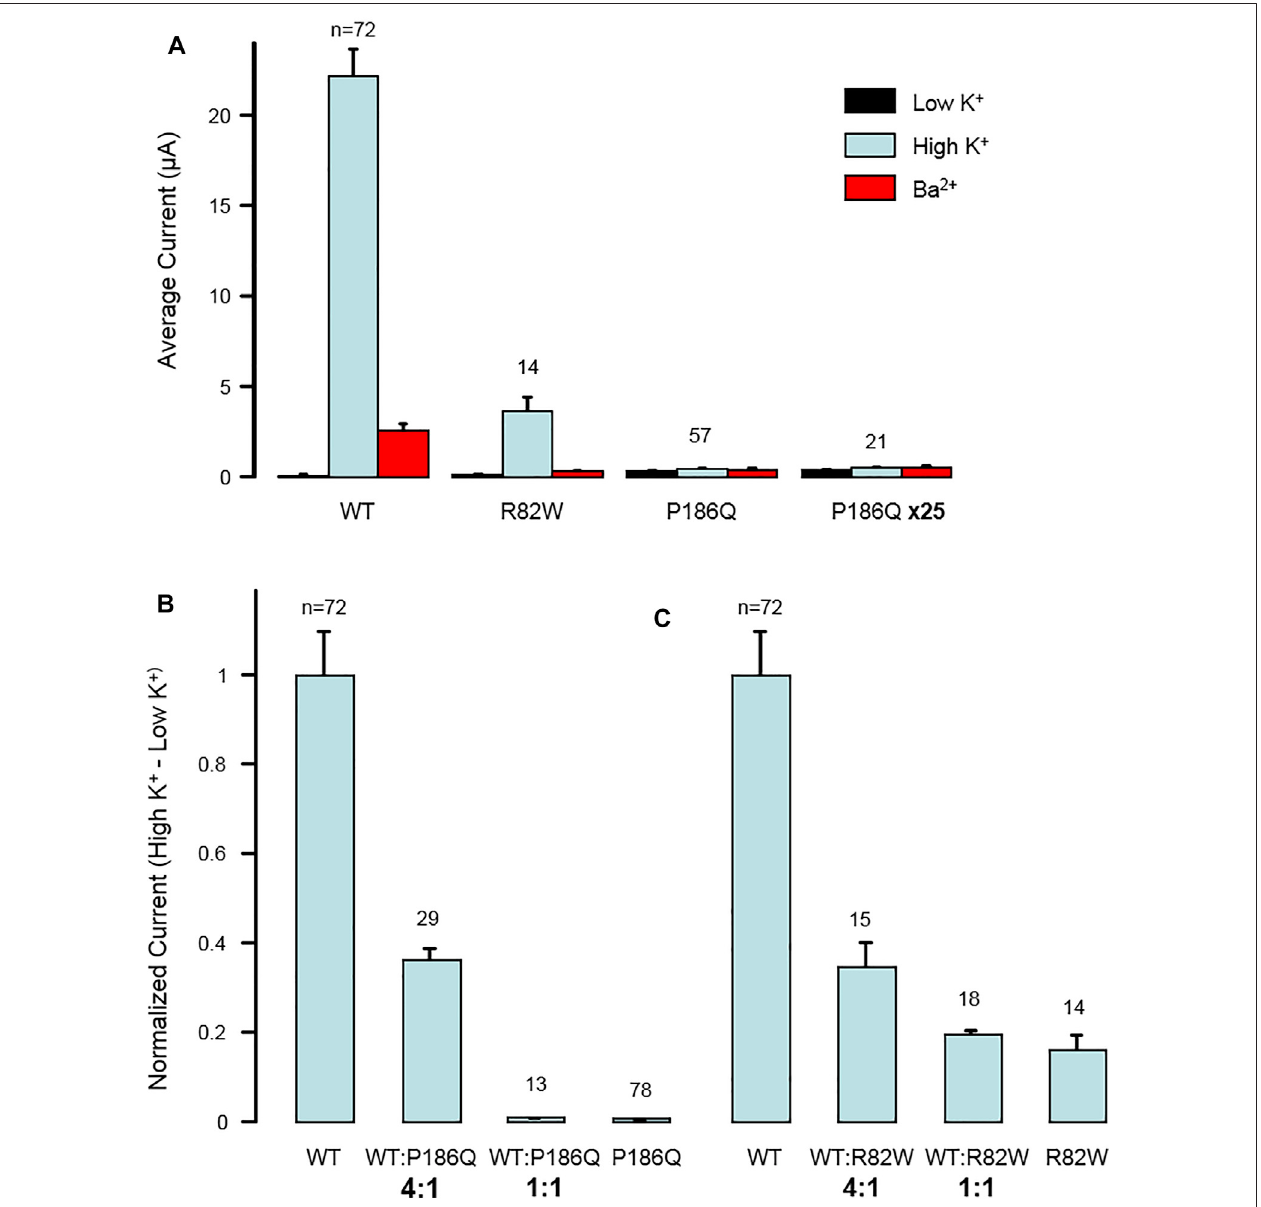
FIGURE 2 | Dominant negative effect of mutations p. Arg82Trp (R82W) and p. Pro186Gln (P186Q) on Kir2.1 function. (A) Mutations reduce the activity of homotetrameric channels. The histogram displays the average whole-cell currents recorded in Xenopus oocytes injected with 2 ng of RNA coding for either wild-type Kir2.1 ( WT ), Kir2.1 R82W ( R82W ), or Kir2.1 P186Q ( P186Q ). Oocytes injected with 50 ng of Kir2.1 P186Q were also tested ( P186Q x25 ). Measurements were done successively in extracellular solutions containing 2 mM K + ( Low K + ), 96 mM K + ( High K + ), and 3 mM Ba 2+ and 96 mM K + ( Ba 2+ ). (B,C) Effect of mutations varies graduallywiththeratioofWTtomutantsubunits. (B) Thehistogramdisplaystheaveragewhole-cellcurrentsrecordedinXenopusoocytesinjectedwithRNAscodingfor wild-typeKir2.1( WT )orKir2.1 P186Q ( P186Q ),orwithamixtureofRNAscodingforWTandmutantwithratiosof4:1or1:1.Thecurrentswerecalculatedasthedifference betweenthecurrentmeasuredinHighK + solutionandthecurrentmeasuredinLowK + solution.TheyareherenormalizedtothecurrentsobtainedwithonlyWTsubunits. (C) Same for mutation R82W. Numbers above bars indicate the number of oocytes included in the averages. Error bars indicate s. e.m.